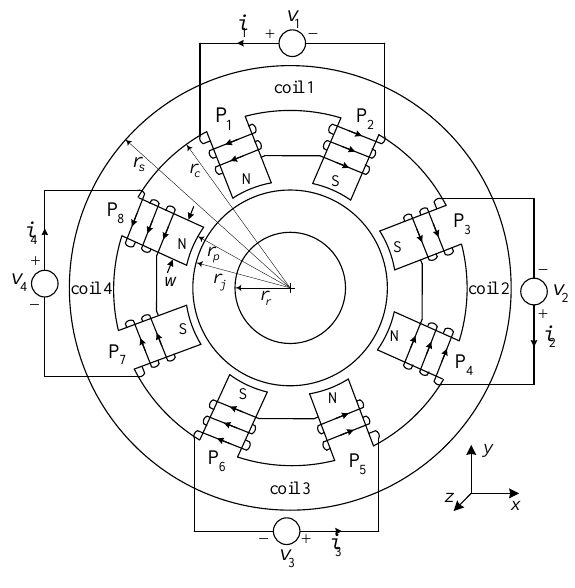
Figure 7. Geometry of an 8-pole heteropolar magnetic bearing.